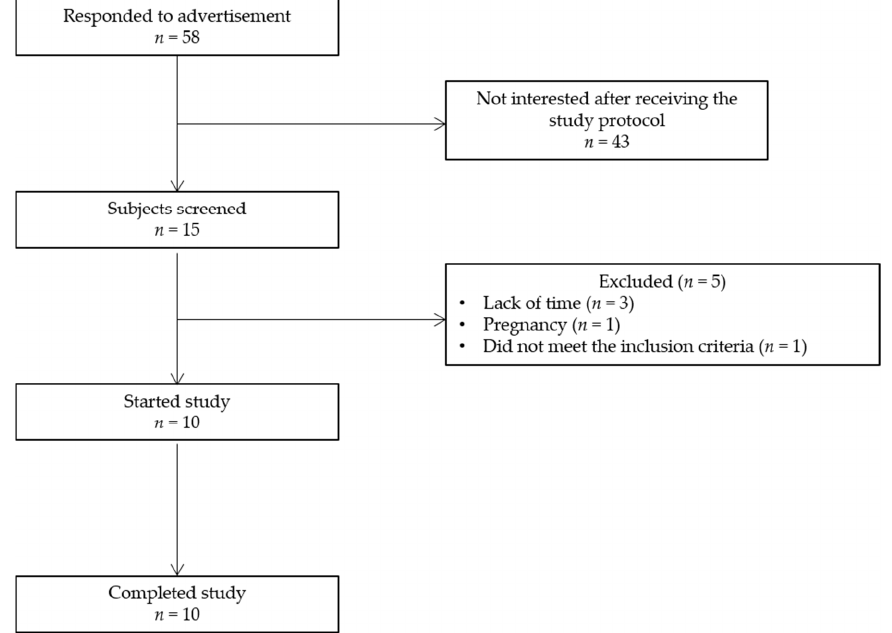
Figure 3. Flow chart depicting the passage of subjects through the study.